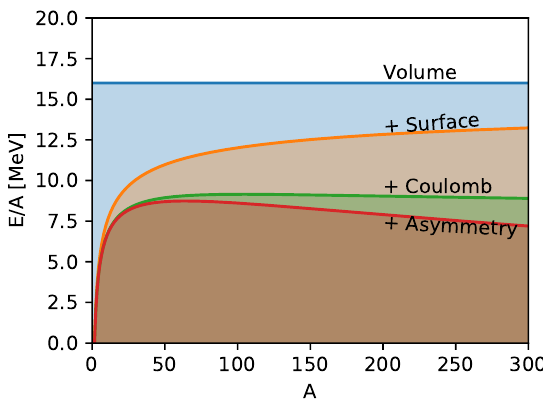
Figure 1. Contributions to nuclear binding from di ff erent terms in the semi-empirical mass formula. Starting from the Volume term, each successive lower line cumulatively adds all previ- ous terms, so the line labelled “ + Asymmetry” includes all four terms. The mass formula coe ffi cients used are as in (2) and (3) except for a surf = − 18 . 5